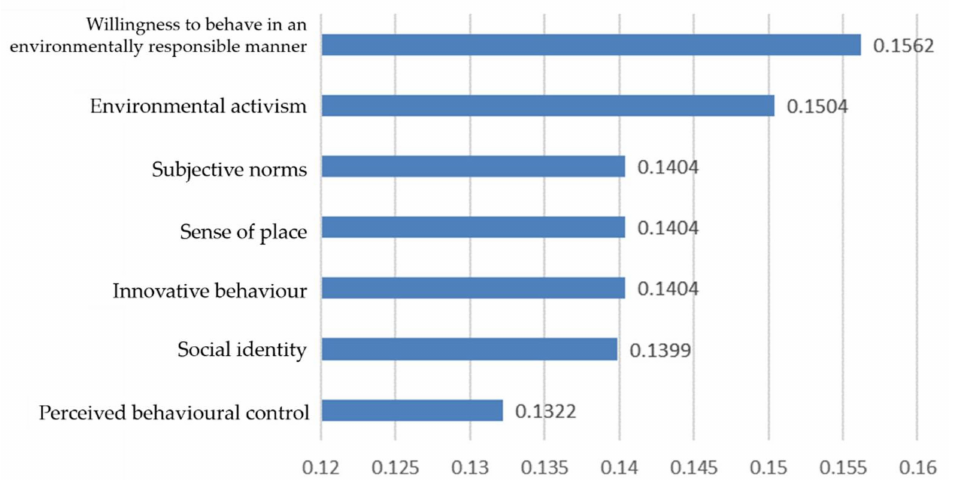
Figure 3. Predictor variables of pro-environmental